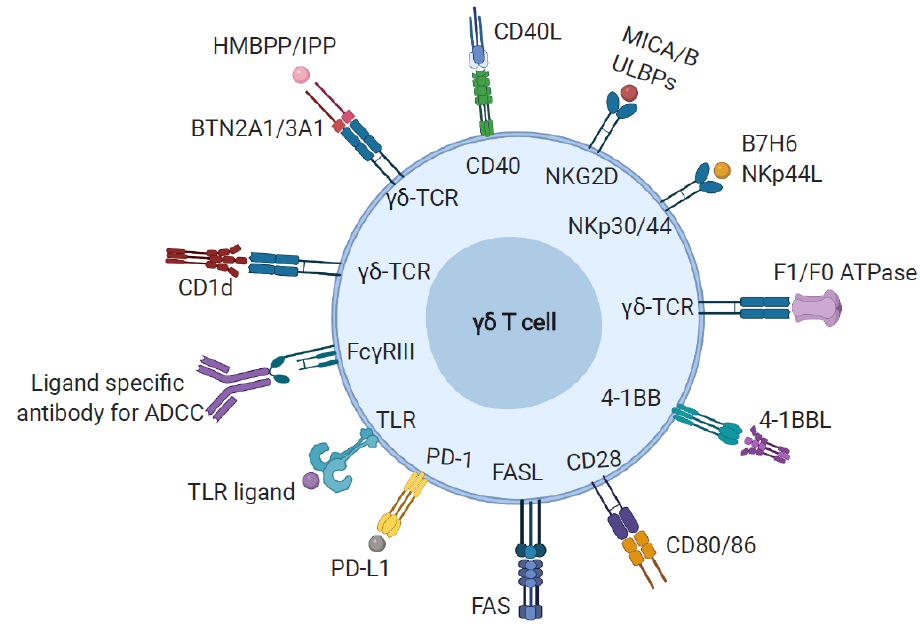
Figure 1. Ligand recognition by gamma delta ( γδ ) T cells. γδ T cells provide a wide range of immunologic functions, recognizing a diverse array of self- and non-self-ligands through their expression of various signaling receptors (depicted in the figure). Abbreviations: HMBPP: (E)-4- Hydroxy-3-methyl-but-2-enyl pyrophosphate, IPP: Isopentenyl pyrophosphate, BTN2A1: Butyrophilin 2A1, ADCC: Antibody-dependent cell-mediated cytotoxicity, TLR: Toll-like receptor, PD1: Programmed cell death protein 1, MICA/B: MHC class I chain-related protein A/B, ULBP- UL16 binding protein, NKG2D: Natural killer group 2D.